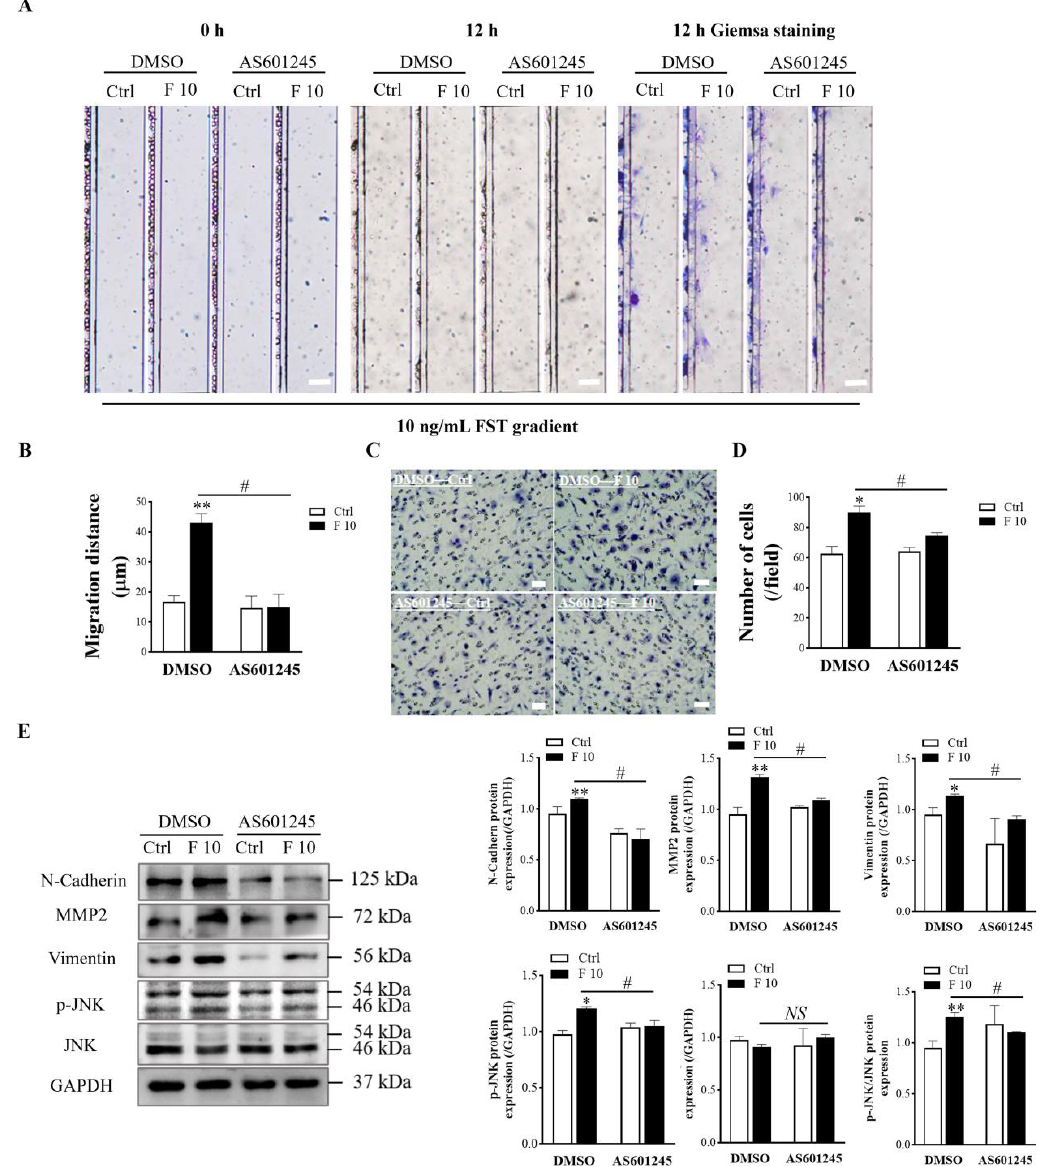
Figure 8. Effects of JNK inhibitor AS601245 on FST-induced migration and invasion of primary cultured trophoblasts of mice. ( A ) The primary cultured trophoblasts were pre-treated for 1 h with vehicle control (DMSO) or 1 μmol/L AS601245, and then migration of trophoblasts was determined by D 4 chip for 12 h. Scale bar = 100 μm. ( B ) The graph showed the average migration distance of cells in the same size fields of microfluidic device ( n = 3). ( C ) The invasion of primary cultured trophoblasts pre-treated with vehicle control (DMSO) or 1 μmol/L AS601245 was determined by Matrigel-coated transwell chamber invasion assay for 12 h. Scale bar = 50 μm. ( D ) The graph represents the average number of stained cells counted in five randomly chosen fields from each chamber ( n = 3). ( E ) Levels of N-Cadherin, MMP2, vimentin, p-JNK, and JNK proteins in trophoblasts pre-treated with vehicle control (DMSO) or 1 μmol/L AS601245 in DMSO were determined by Western blotting with GAPDH as the internal control protein. The graph represents the relative level of proteins ( n = 3). Ctrl: 2% FBS culture medium control. F10: 10 ng/mL of FST. * p < 0.05, ** p < 0.01, compared with vehicle control. # p < 0.05. compared with the indicted DMSO group.